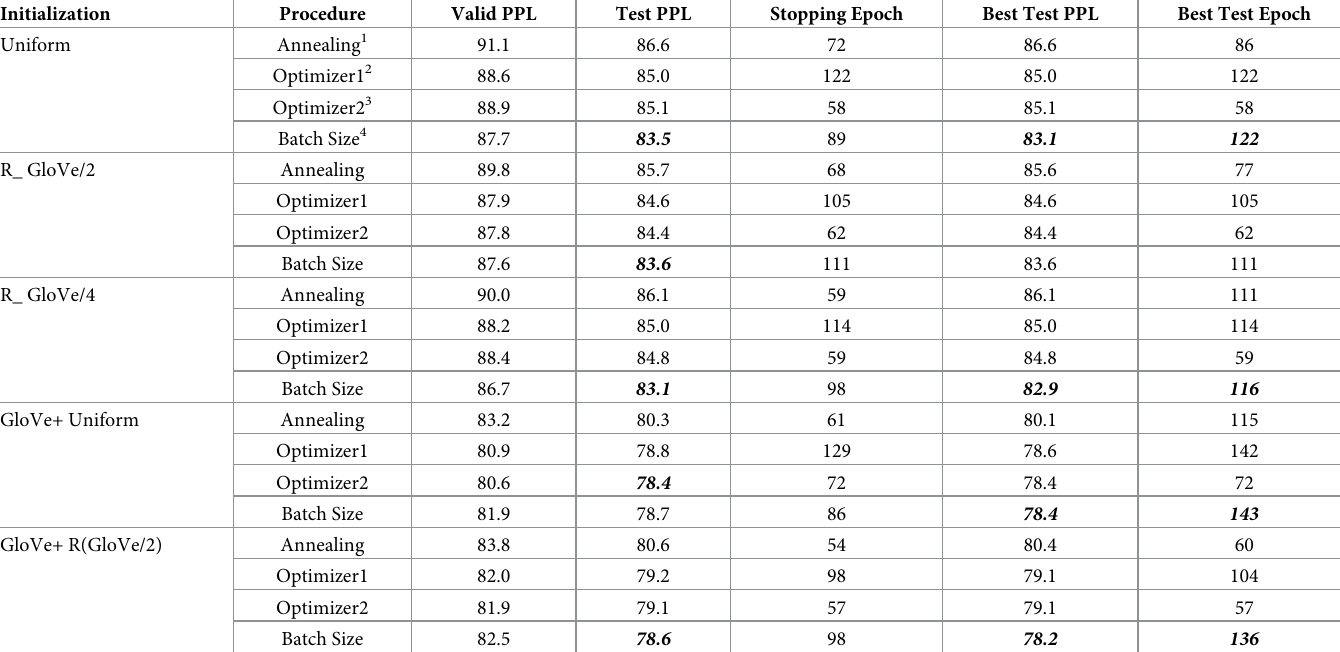
Table 7. Perplexity of different initializations and improvement